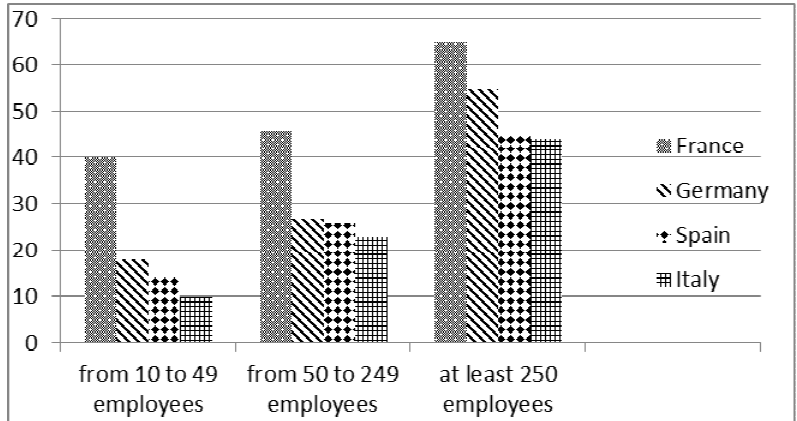
Figure 1: Innovative Manufacturing Companies by Size with Cooperation Agreements for Innovation, 2008